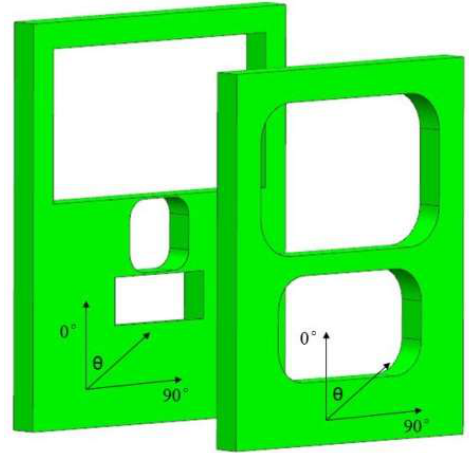
Figure 5. Support structure made of carbon-fiber-reinforced plastic.